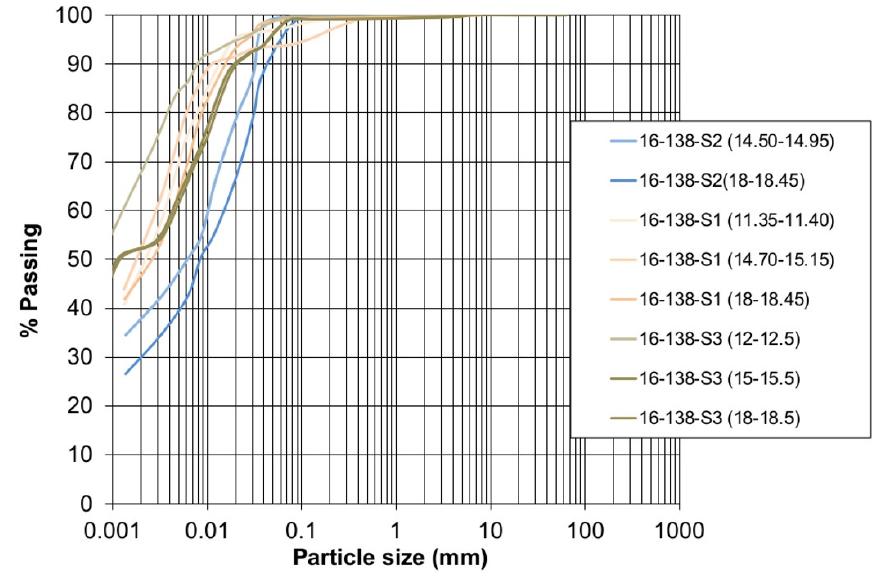
Figure 6. Particle size distribution curves for clayey silt (La) and clay (A) deeper than 10 m. Table 1. Correspondence among the soil classification from Schmertmann (1978) [36] and SBTn from Robertson (1990) [37] and the lithological classes (LC) detected using the borehole